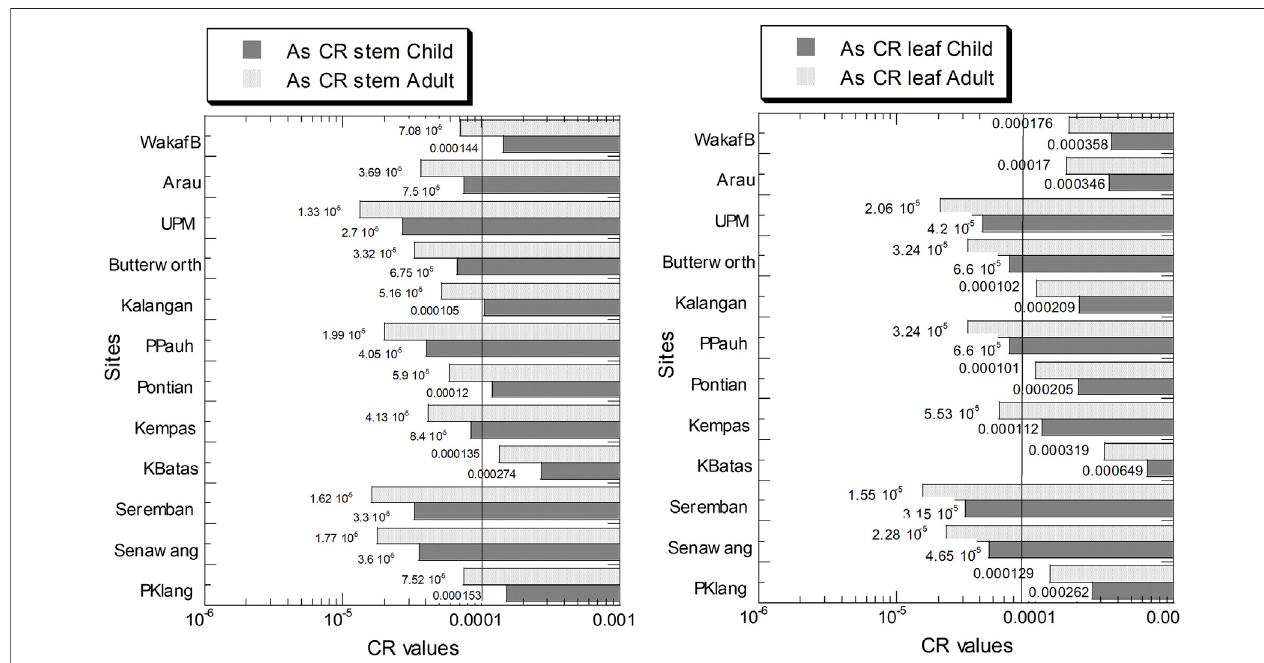
FIGURE 6 | Carcinogenic risk (CR) of As in the leaves and stems of Centella asiatica collected from 12 sampling sites (numbers in white circles (1 – 12) in Figure 1 ; S1 – S12 in Supplementary Table S1 ) in Peninsular Malaysia. The X -axes are based on a logarithmic scale.